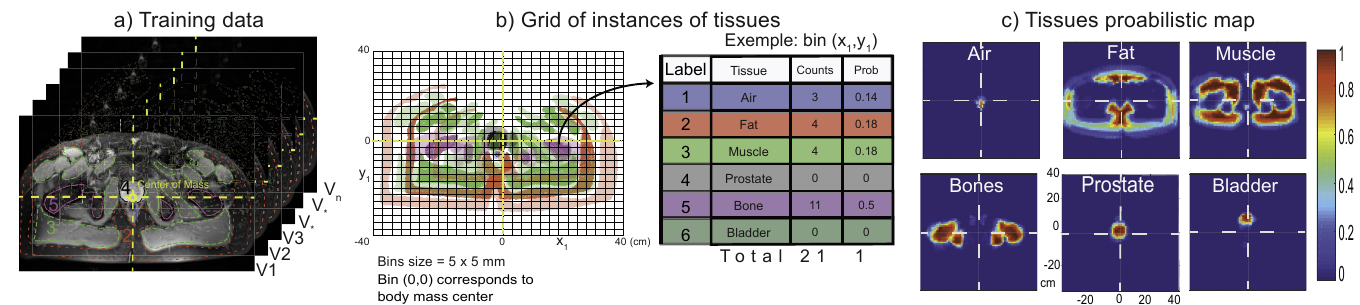
Fig 5. Probabilistic shape prior creation. Starting from training images, the center of mass is localized (a). Then, every voxel in the ROIs is translated into an accumulator grid (b) and the instances of every different tissue in the different bins are counted to create the probabilistic map (c). From the probabilistic map, six- features descriptors are formed: air, fat, muscle, bone marrow, prostate and